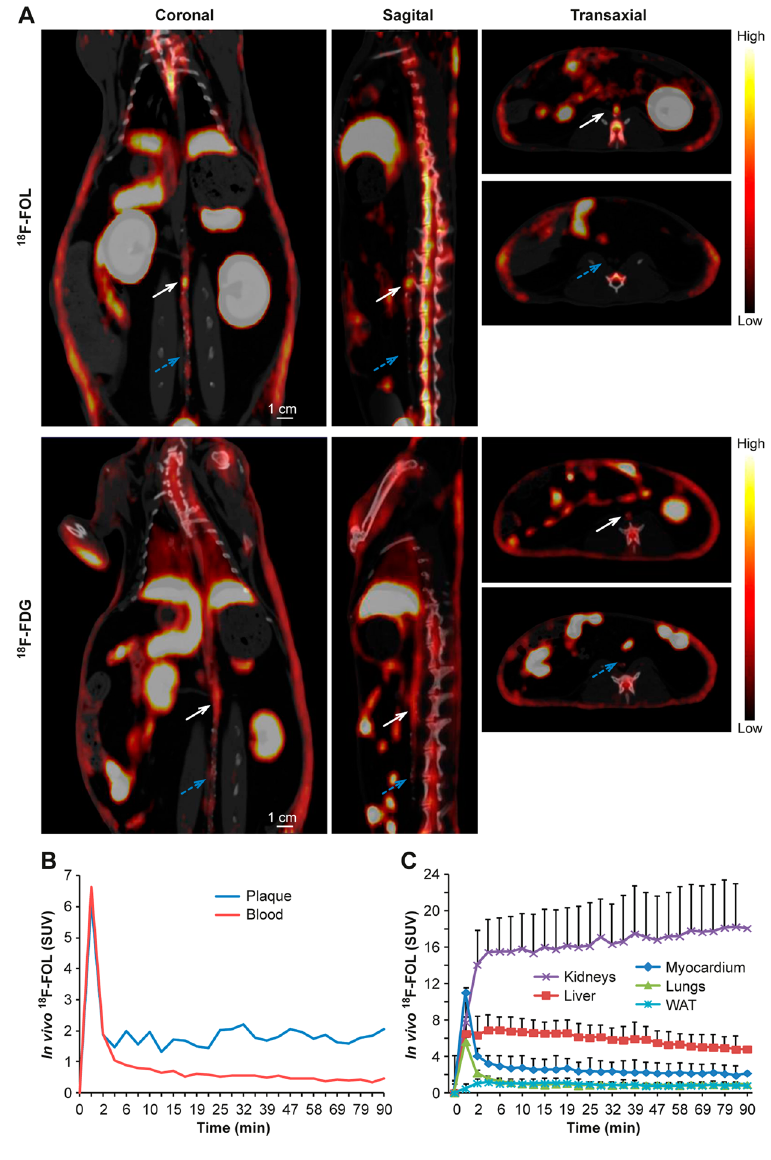
Figure 5. 18 F-FOL PET/CT imaging of rabbits. ( A ) Representative coronal views of in vivo PET/CT images of a rabbit (3.4 kg, tracer doses 40 MBq/kg) with 18 F-FOL (88–90 min post-injection) and 18 F-FDG (170–180 min post-injection). White arrows denote a segment with advanced atherosclerosis in the abdominal aorta, with an 18 F-FOL maximum target-to-background ratio (TBR = maximum standardized uptake value (SUV) of aorta divided by mean SUV of blood as determined from the inferior vena cava, SUV max, aorta /SUV mean, blood ) of 6.0 and an 18 F-FDG maximum TBR of 2.4. Enlarged coronal PET/CT images of the aorta are shown in the right panels. Blue arrows denote aorta with lower tracer uptake. PET images are displayed in the same color scale. ( B ) Representative 18 F-FOL time-activity curves of plaque (white arrow in Figure A) and blood. ( C ) Distribution kinetics of 18 F-FOL in the selected organs (mean ± SD, n =